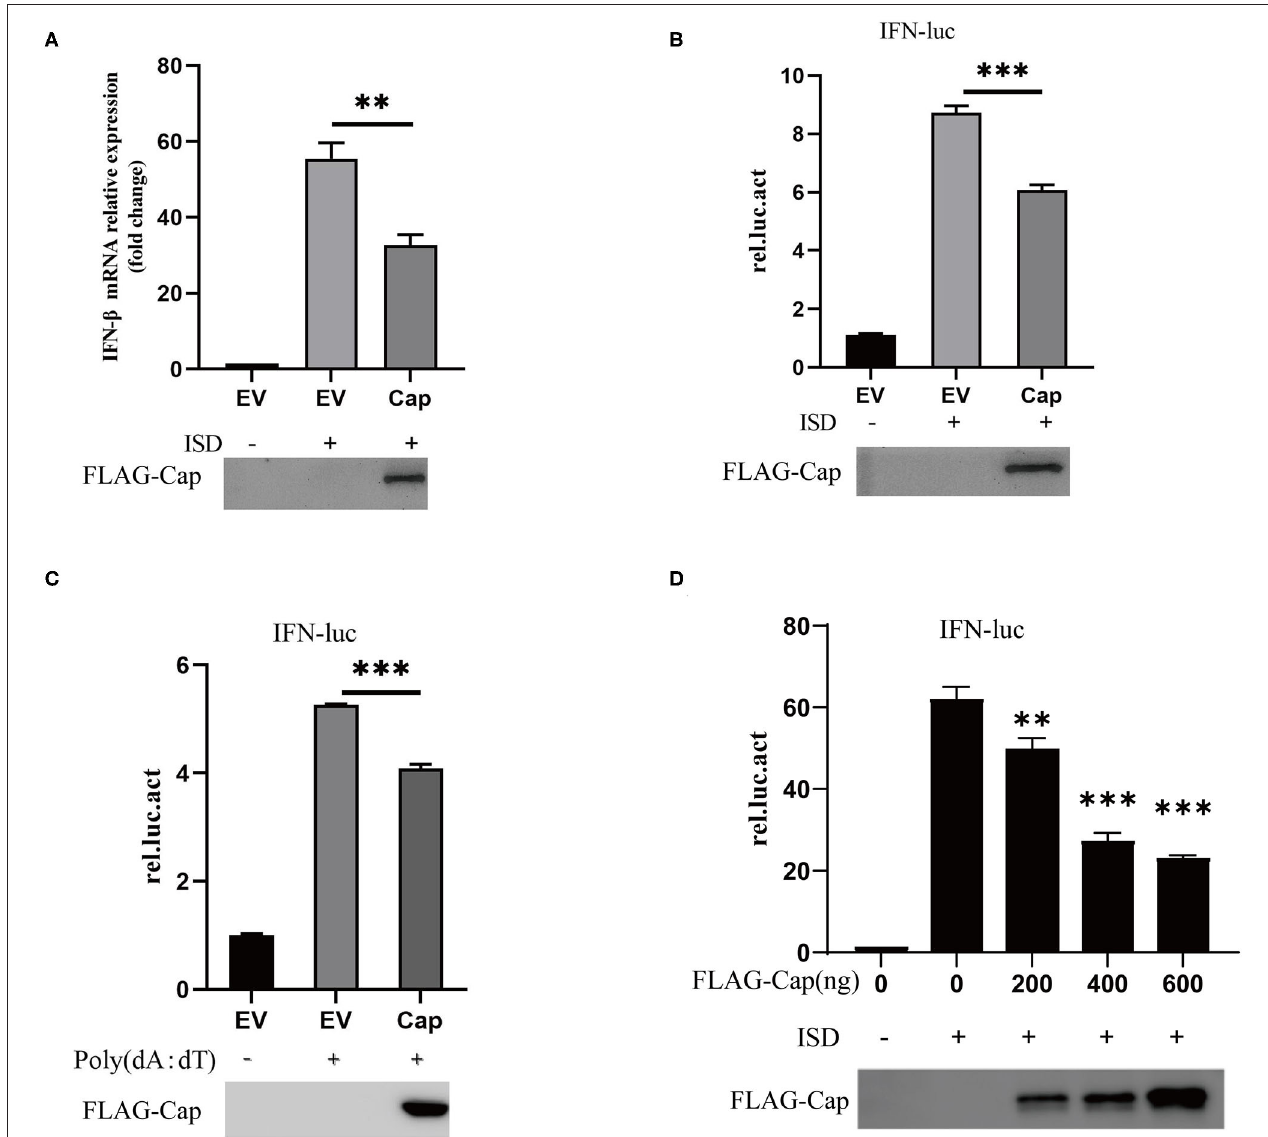
FIGURE 1 | PCV3 Cap inhibits DNA-induced IFN- β production. (A) qPCR analysis of IFN- β mRNA in PK15 cells transfected with FLAG empty vector (EV) or the FLAG-Cap expression vector and stimulated with 2 µ g/ml of ISD for 6h at 24h post-transfection. (B–D) Cap inhibits DNA-induced IFN promoter activation. Cells were co-transfected with 100 ng IFN-luc, 50 ng TK-luc, and 500 ng FLAG-Cap or the EV. After 24h, the cells were stimulated by transfection with 2 µ g/ml ISD (B) or 1 µ g Poly (dA:dT) (C) for another 12h and then lysed with cell lysis buffer for a dual-luciferase assay. (D) PK15 cells were transfected with the indicated amount of the FLAG-Cap expression vector. The results represent data from three independent experiments, * p < 0.01; *** p <